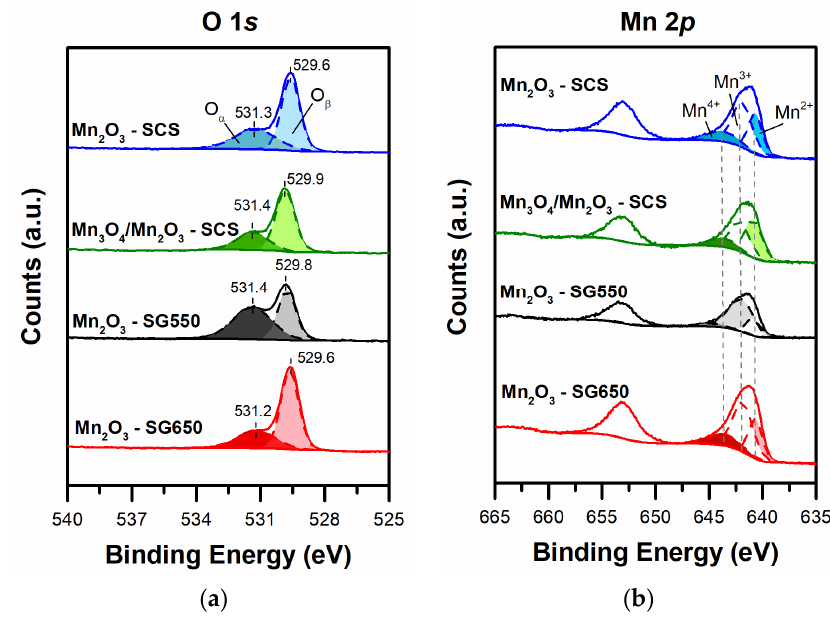
Figure 5. XPS spectra in the ( a ) O 1s (section a) and ( b ) Mn 2p core level.